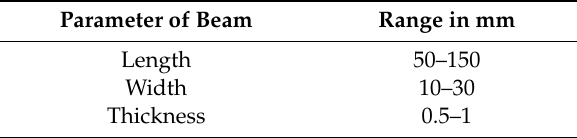
Table 3. Ranges of dimensions for parametric analysis.